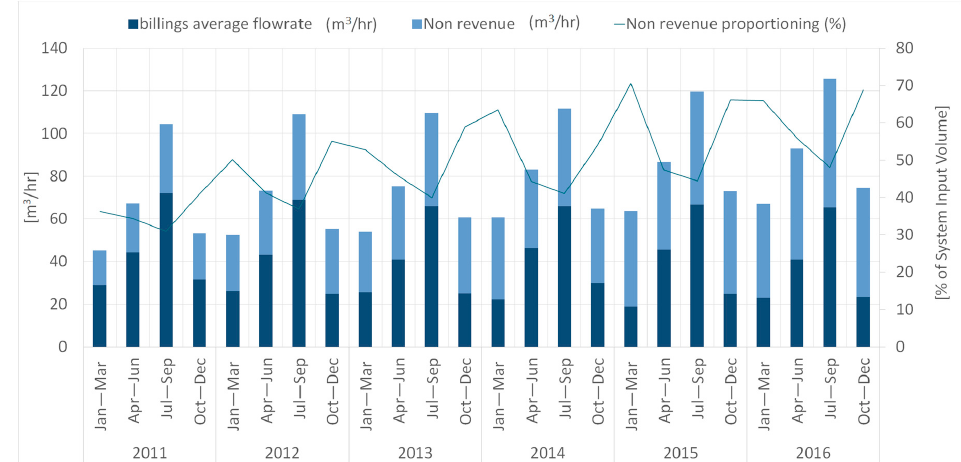
Figure 2. Skiathos water supply systems (WSS) quarterly system input volume (SIV), revenue, nonrevenue water (NRW), and fraction of SIV corresponding to NRW from January 2011 to December 2016.